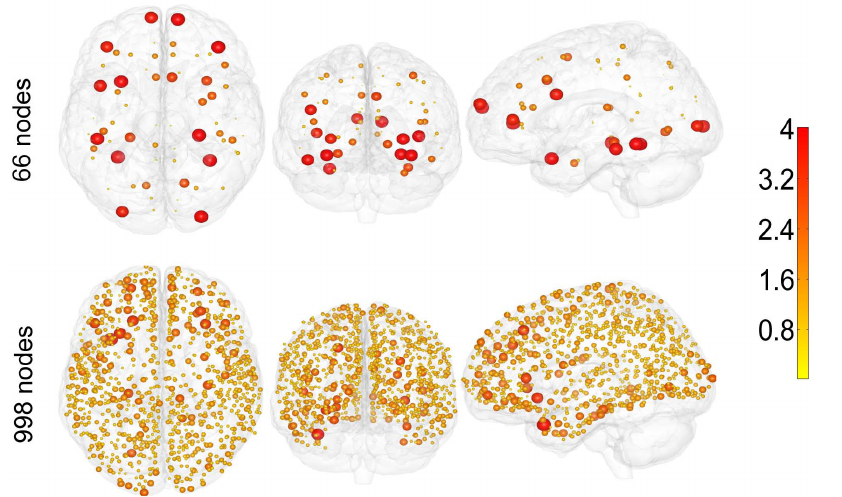
Figure 3. Localization of areas which are bottlenecks of information. The value of r for each region for the Ising model on brain networks, for the 66-nodes connectome (top) and the 998 nodes one (bottom). The size of the spheres is proportional to r, thus showing the most prone regions to became bottlenecks of information.